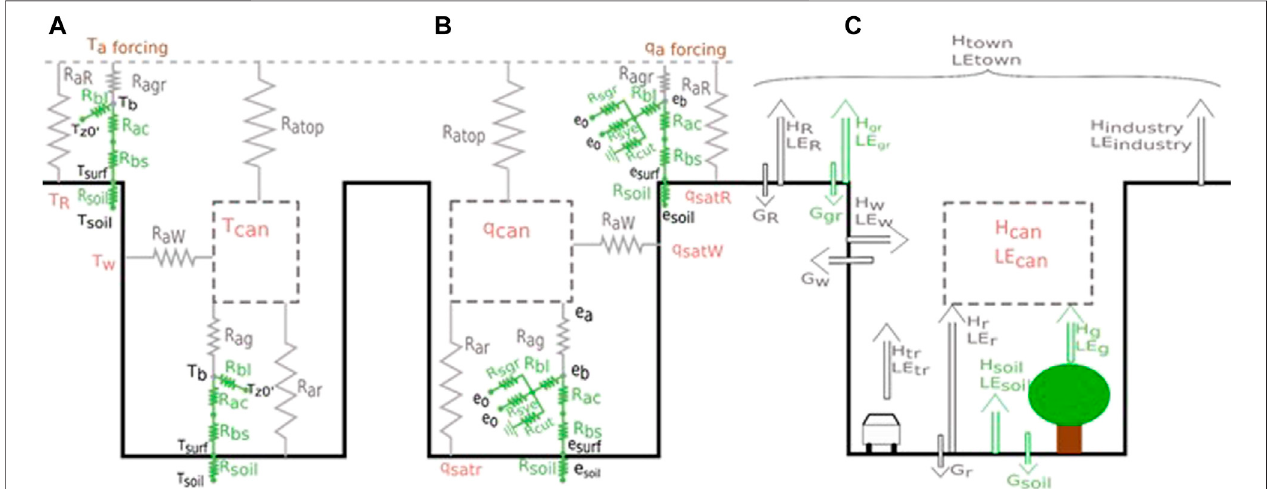
FIGURE 2 | Resistive scheme of the TEB-Surfatm model for: (A) heat exchanges, (B) water vapour exchanges, and (C) energy budget. Ra r , Ra g , Ra R , Ra gr , Ra w , R bl , R sgr , R sye , R cut , R ac , R bs , R soil refer to aerodynamic resistances of the road, garden, roof, green roof, wall, leaf boundary layer resistance, the stomatal resistances of the green leaf and yellow leaf, the cuticular resistance, canopy aerodynamic resistance, soil boundary layer resistance, and soil resistance, respectively. e, q, qsat, T, H, LE, G refer to the water vapour partial pressure, speci fi c humidity, saturation humidity, temperature, sensible and latent heat fl uxes and the conductive fl ux, respectively. Brown scalars T a forcing and q a forcing are inputs. Grey and green resistances and fl uxes refers to thosecalculated byTEB and Surfatm, respectively. Red and black scalars refer to those calculated by TEB and Surfatm, respectively.